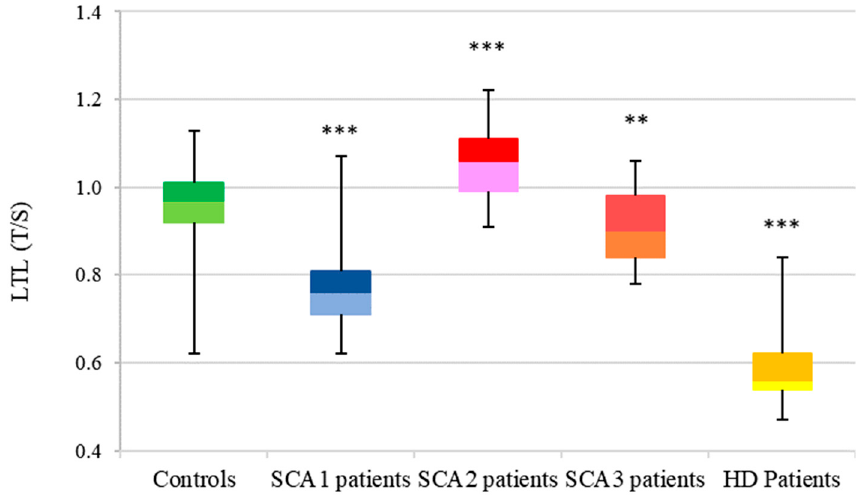
Figure 8. Distribution of LTL in CAG diseases. Box plot showing the distribution of LTL (T/S ratio) in controls (n = 146) (median: 0.97, Q1: 0.92, Q3: 1.01) and CAG repeat diseases: SCA1 patients (n = 52) (median: 0.75, Q1: 0.70, Q3: 0.80), SCA2 patients (n = 26) (median: 1.06, Q1: 1, Q3: 1.12), SCA3 patients (n = 29) (median: 0.90, Q1: 0.84, Q3: 0.0.98), and HD patients (n = 62) (median: 0.56, Q1: 0.53, Q3: 0.62). HD data from [31]. (** p < 0.01; *** p < 0.001 patients vs. controls). There are